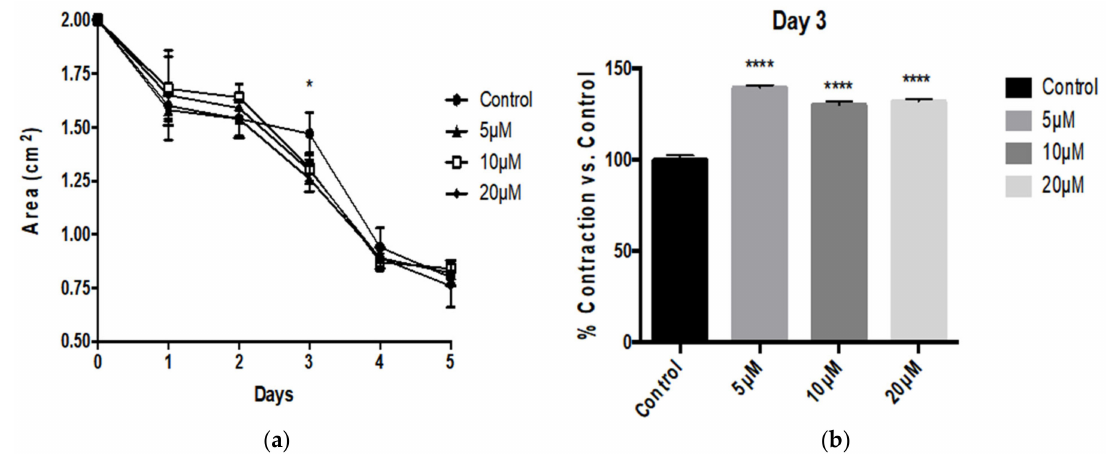
Figure 3. A β 25-35 peptide enhanced HBVSMC contractility. ( a ) HBVSMC in collagen gel treated with various concentrations of A β 25-35 exhibit a smaller area at 3 days of treatment. This effect was not observed after 4 days of treatment. ( b ) At 3 days in culture, A β 25-35 treatment significantly enhanced HBVSMC contractility at all concentrations tested, from 1–50 µ M compared with control n = 4, * p < 0.05, **** p <0.0001 versus control; one-way ANOVA with Dunnett’s post-testing; data shown are mean ±